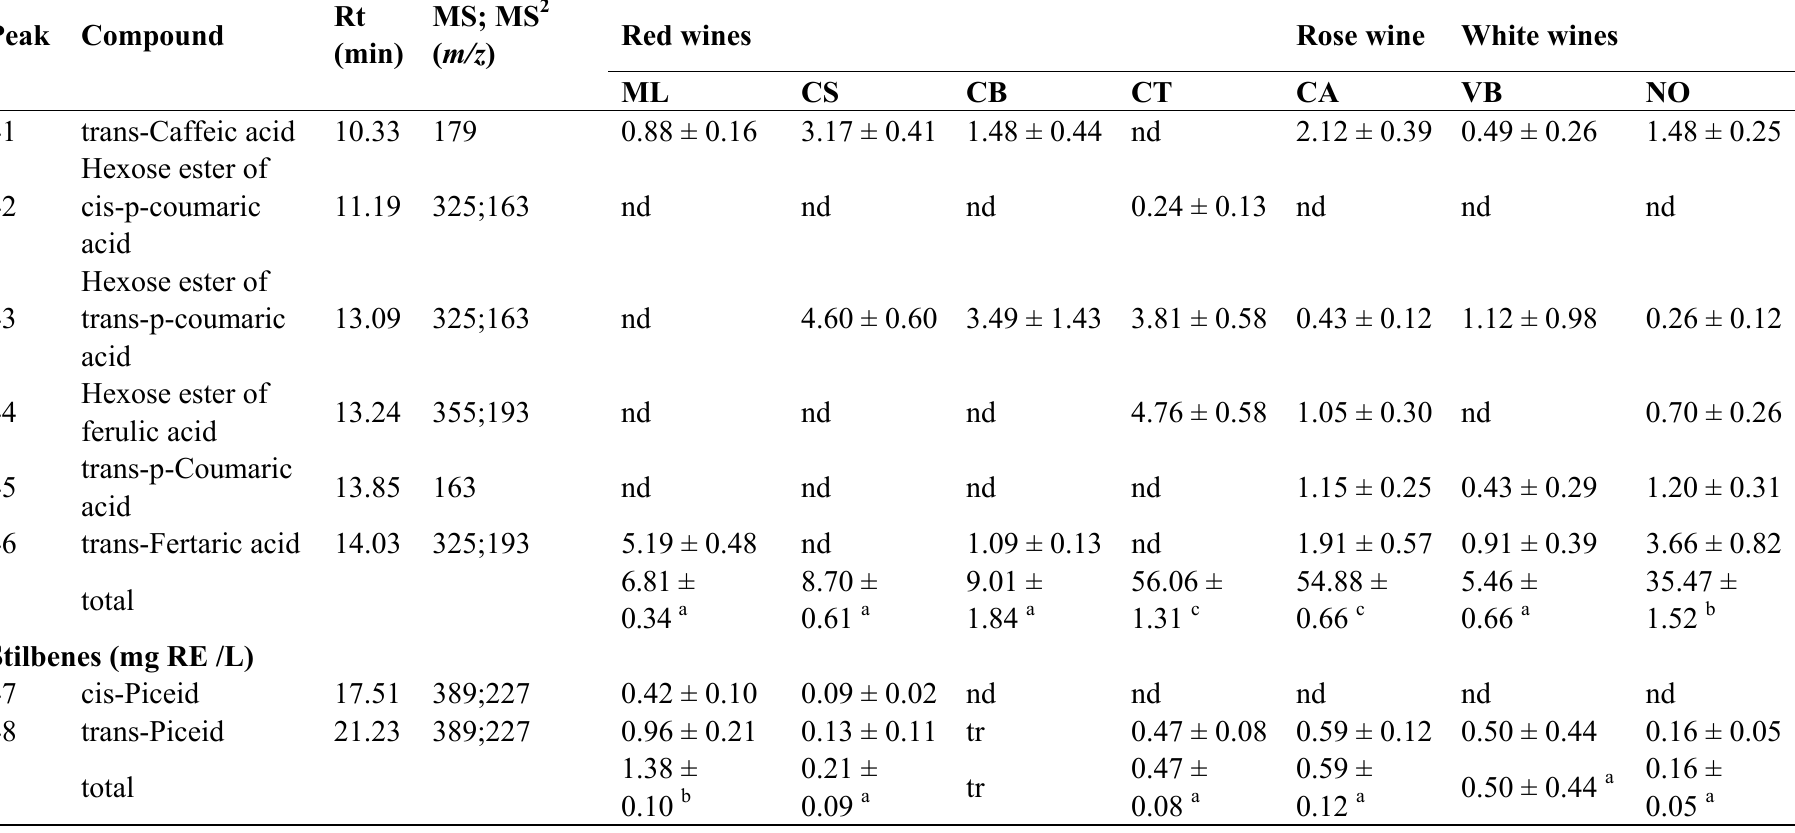
The abbreviations of the cultivars are the same as Table 1. Values are means of duplicate determination±S.D. Dq, dihydroquercetin; Q, quercetin;